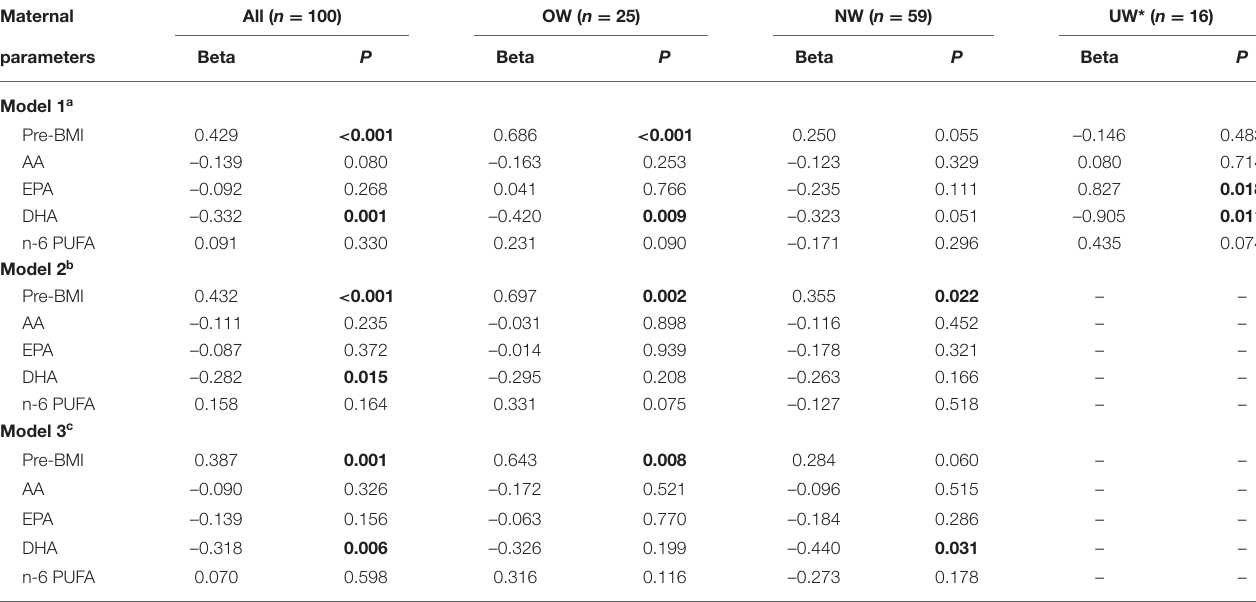
TABLE 5 | Linear regression analysis on the correlation of maternal parameters and fetal cord plasma n-6/n-3. Maternal All ( n = 100) OW ( n = 25)